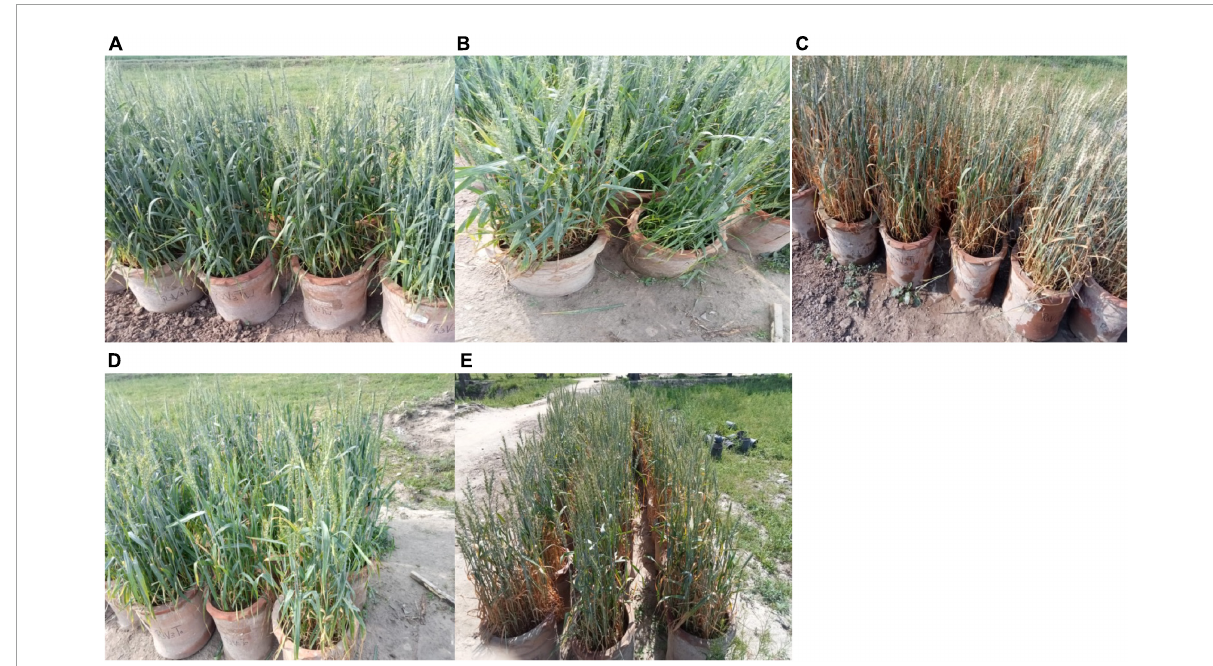
FIGURE6 Pictorial view of wheat crop under (A) ambient environment post anthesis (B) 4 days and (C) 8 days heat stress (D) foliar spray of potassium in post anthesis 4 days, and (E) 8 days heat